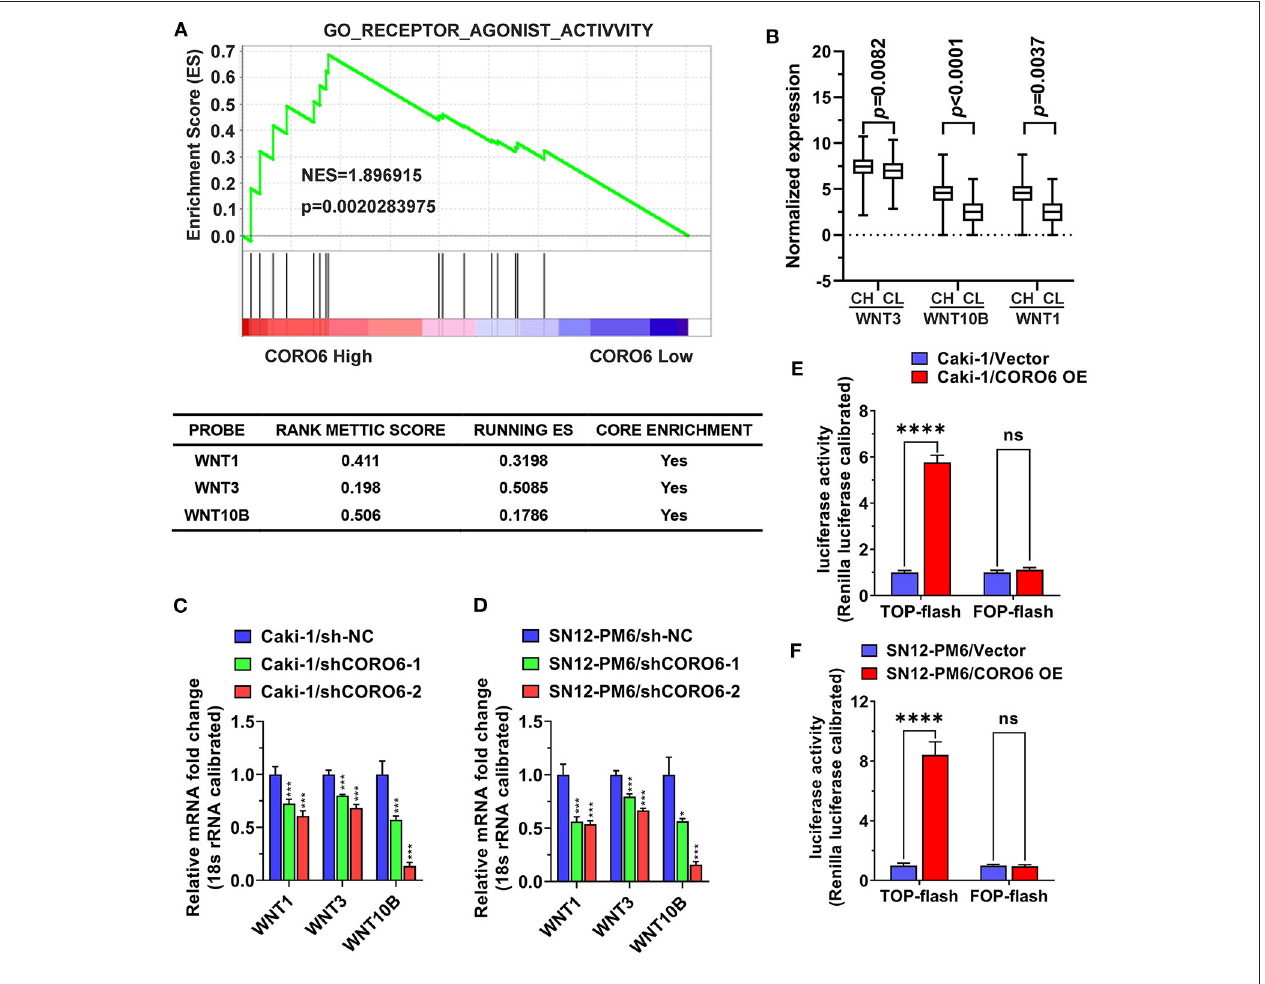
FIGURE 7 | Mechanistic dissection of how CORO6 promoted ccRCC progression. (A) GSEA KEGG analyses showed that GO receptor agonist activity was highly enriched in the high CORO6 group. (B) The expression levels of WNT1, WNT3, and WNT10B increased in ccRCC patients with a high level of CORO6. (C,D) CORO6 knockdown dramatically reduced the expression levels of WNT1, WNT3, and WNT10B in both Caki-1 (C) and SN12-PM6 cells (D) . The expression levels of detected genes were normalized to 18s rRNA. (E,F) CORO6 enhanced the activity of TOPflash but not FOPflash in both Caki-1 (E) and SN12-PM6 cells (F) . * P < 0.05, *** P < 0.001, and **** P < 0.0001. Ns, no